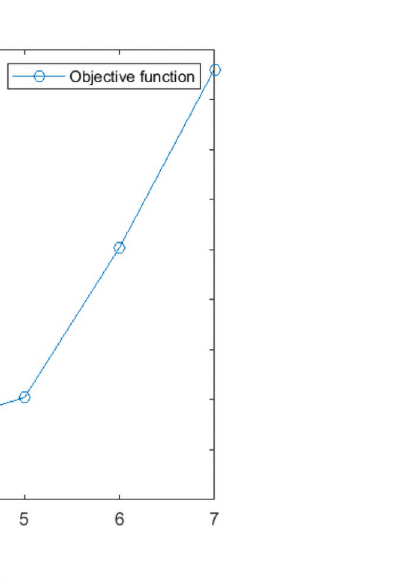
Fig 6. Objective function for different optimization times steps.